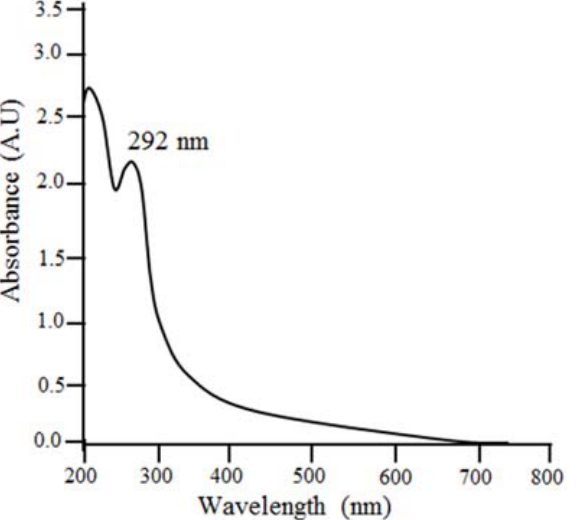
Figure 2. UV – visible spectroscopy of SNPs from leaves of Citrus limon.